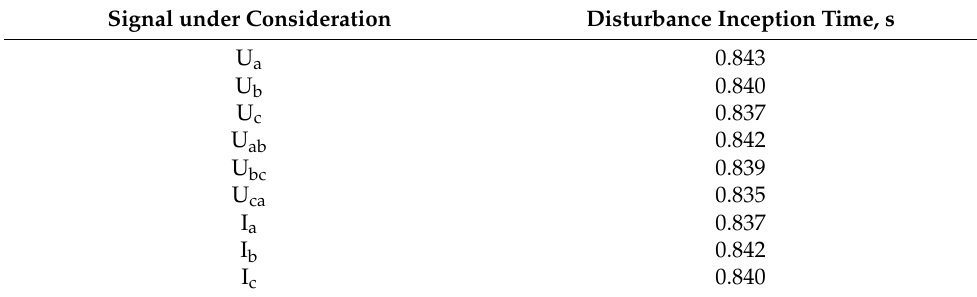
Table 5. Comparison of the results for algorithm 1 after accuracy improvement.